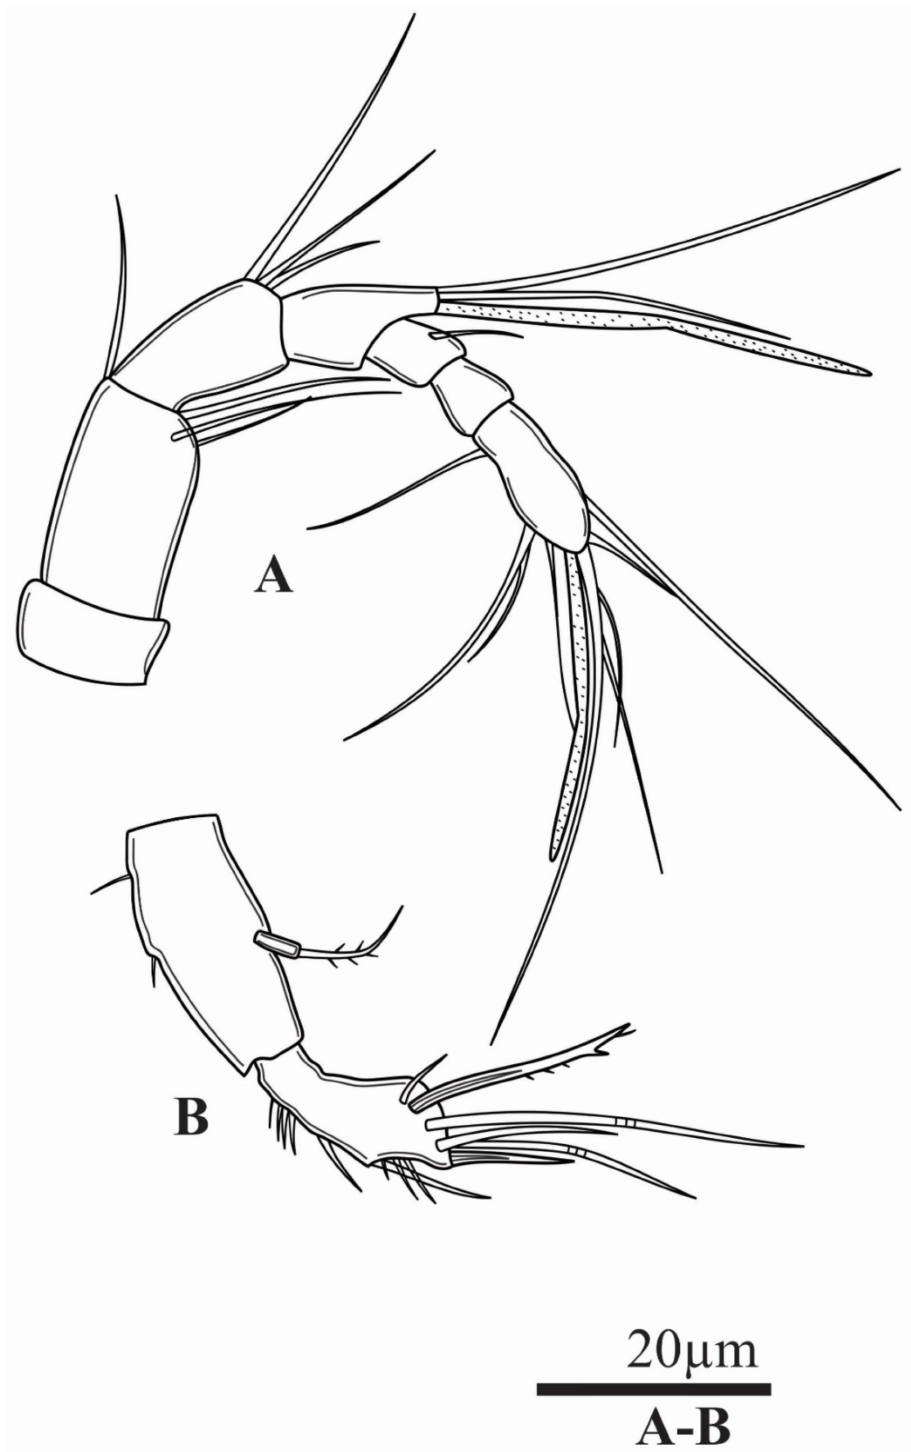
Figure 3. Parastenocaris sontraensis sp. nov. holotype female. ( A ), antennule; ( B ),